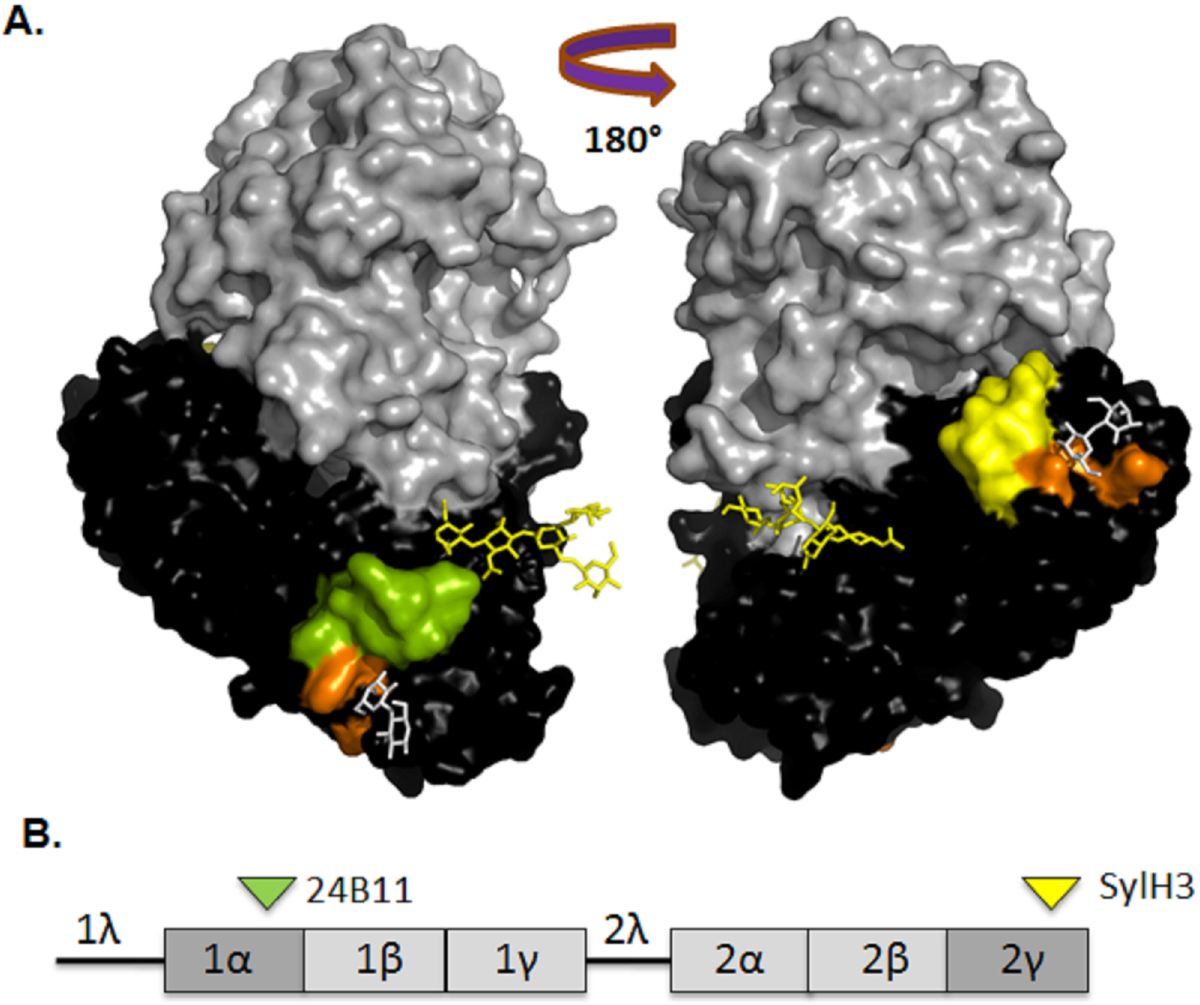
Fig 1. Localization of neutralizing epitopes on RTB. (A) A 3D surface representation of ricin toxin derived using PyMOL (PDB ID 2AAI). The followingelementsare highlighted:RTA (grey), RTB (black), putative 24B11 epitope(green), putative SylH3 epitope(yellow), CRD (orange), N-linkedmannoseside chains (yellowsticks), and lactose moieties (white sticks). (B) Lineardepictionof RTB showingdomains(1 and 2), as well as individualsub-domains (1 α , 1 β , 1 γ , 2 α , 2 β , 2 γ ). 1 λ is a peptidelinker connectingRTA to RTB in the ricin pre-protein, while 2 λ connects the two RTB domains.The green and yellow arrowhead indicate proposed location of 24B11 and SylH3’s epitope,